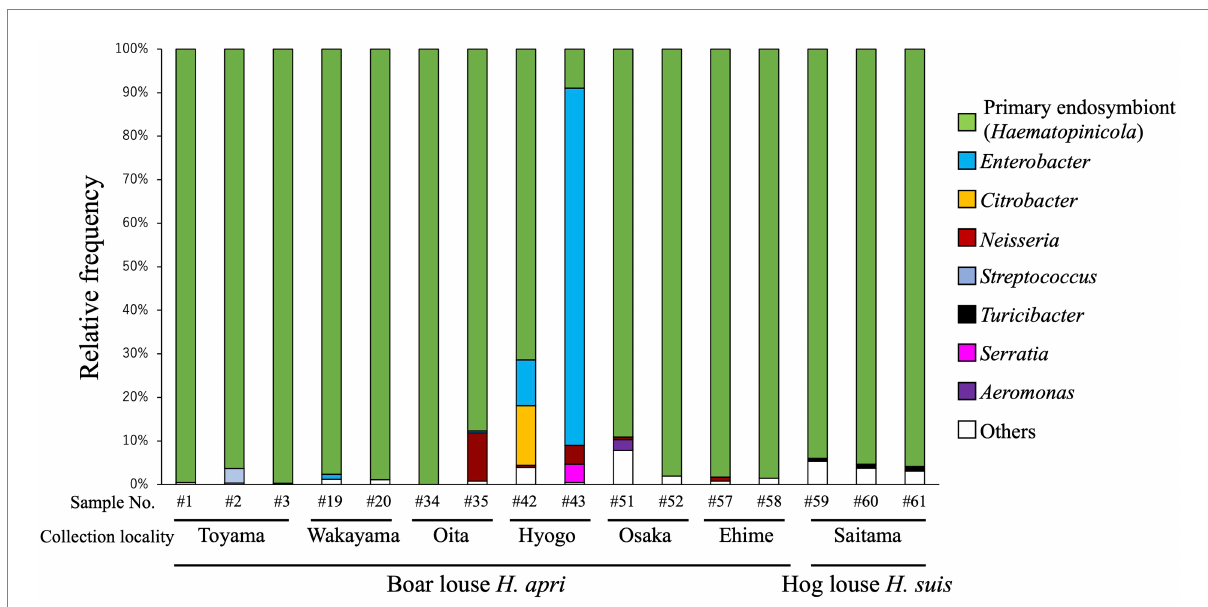
FIGURE 1 Bacterial diversity associated with the boar louse Haematopinus apri and the hog louse Haematopinus suis based on amplicon sequencing data of the hypervariable V3/V4 region of 16S rRNA gene. Assigned bacterial taxa are color-coded as shown on the right side. As for sample information and amplicon sequencing data, see Supplementary Table